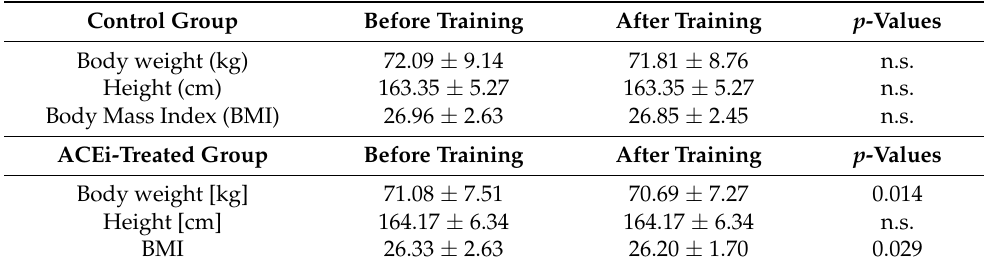
Table 2. Anthropometric parameters of patients.